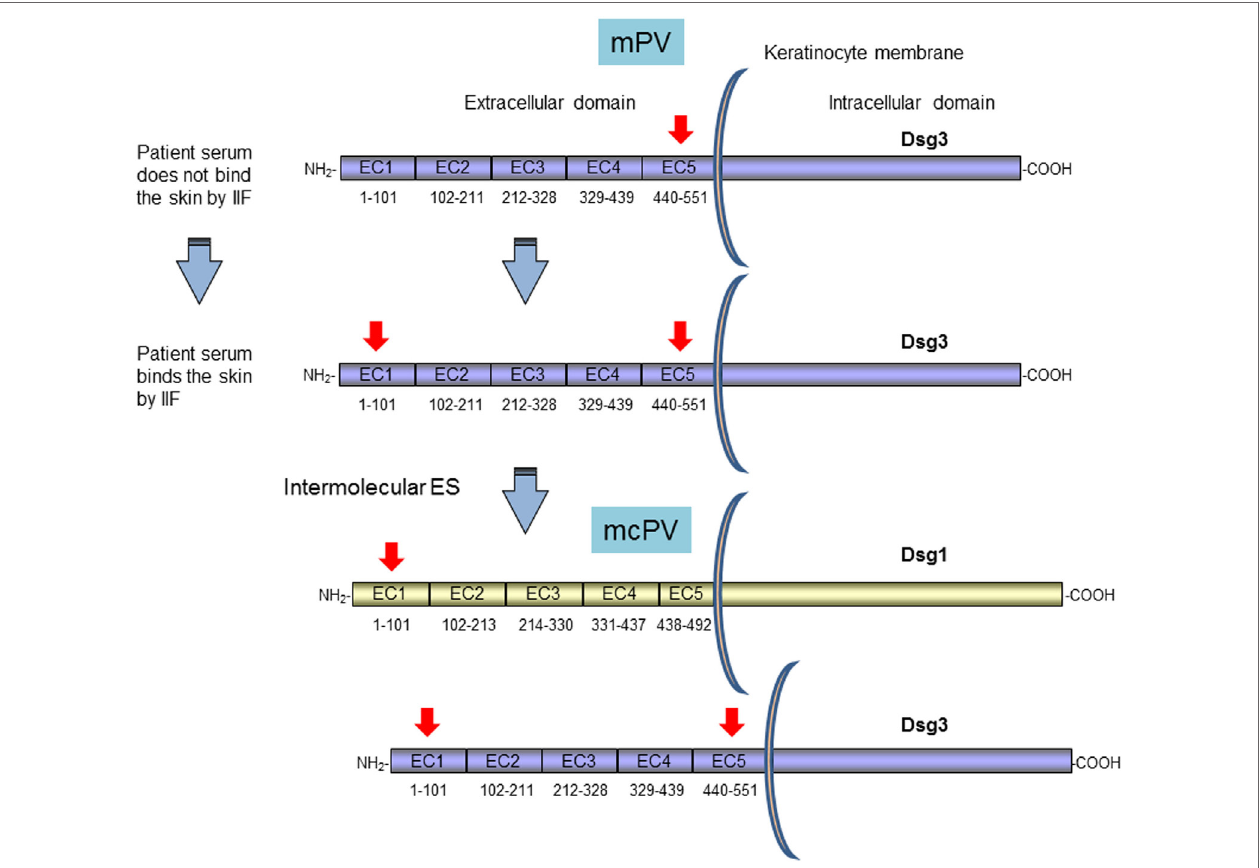
FiGURe 2 | Clinical transition between mucosal pemphigus vulgaris (PV) to mucocutaneous PV as proposed by Salato et al. Survey and schematic representation of the antigenic regions recognized by autoantibodies of a representative PV patient with only mucosal involvement (mPV) that shift clinical phenotype to mucocutaneous one (mcPV) (76). PV antigens (Dsg1 and Dsg3) with relative subdomains (EC1–EC5) of Dsg1 and 3 and their amino acid sequences are illustrated. Red arrows indicate the regions recognized by patient autoantibodies during the course of the disease (76). The mPV patient at an early stage of disease has autoantibodies specific for ectodomain (EC5) subdomain. At this time the circulating autoantibodies are not able to bind human skin by [indirect immunofluorescence (IIF)]. Several years later, the patient produces autoantibodies directed to EC1 by an intramolecular ES phenomenon. At this stage the autoantibodies start to bind the human skin and an intermolecular ES toward Dsg1 occurred with development of cutaneous as well as mucosal blisters